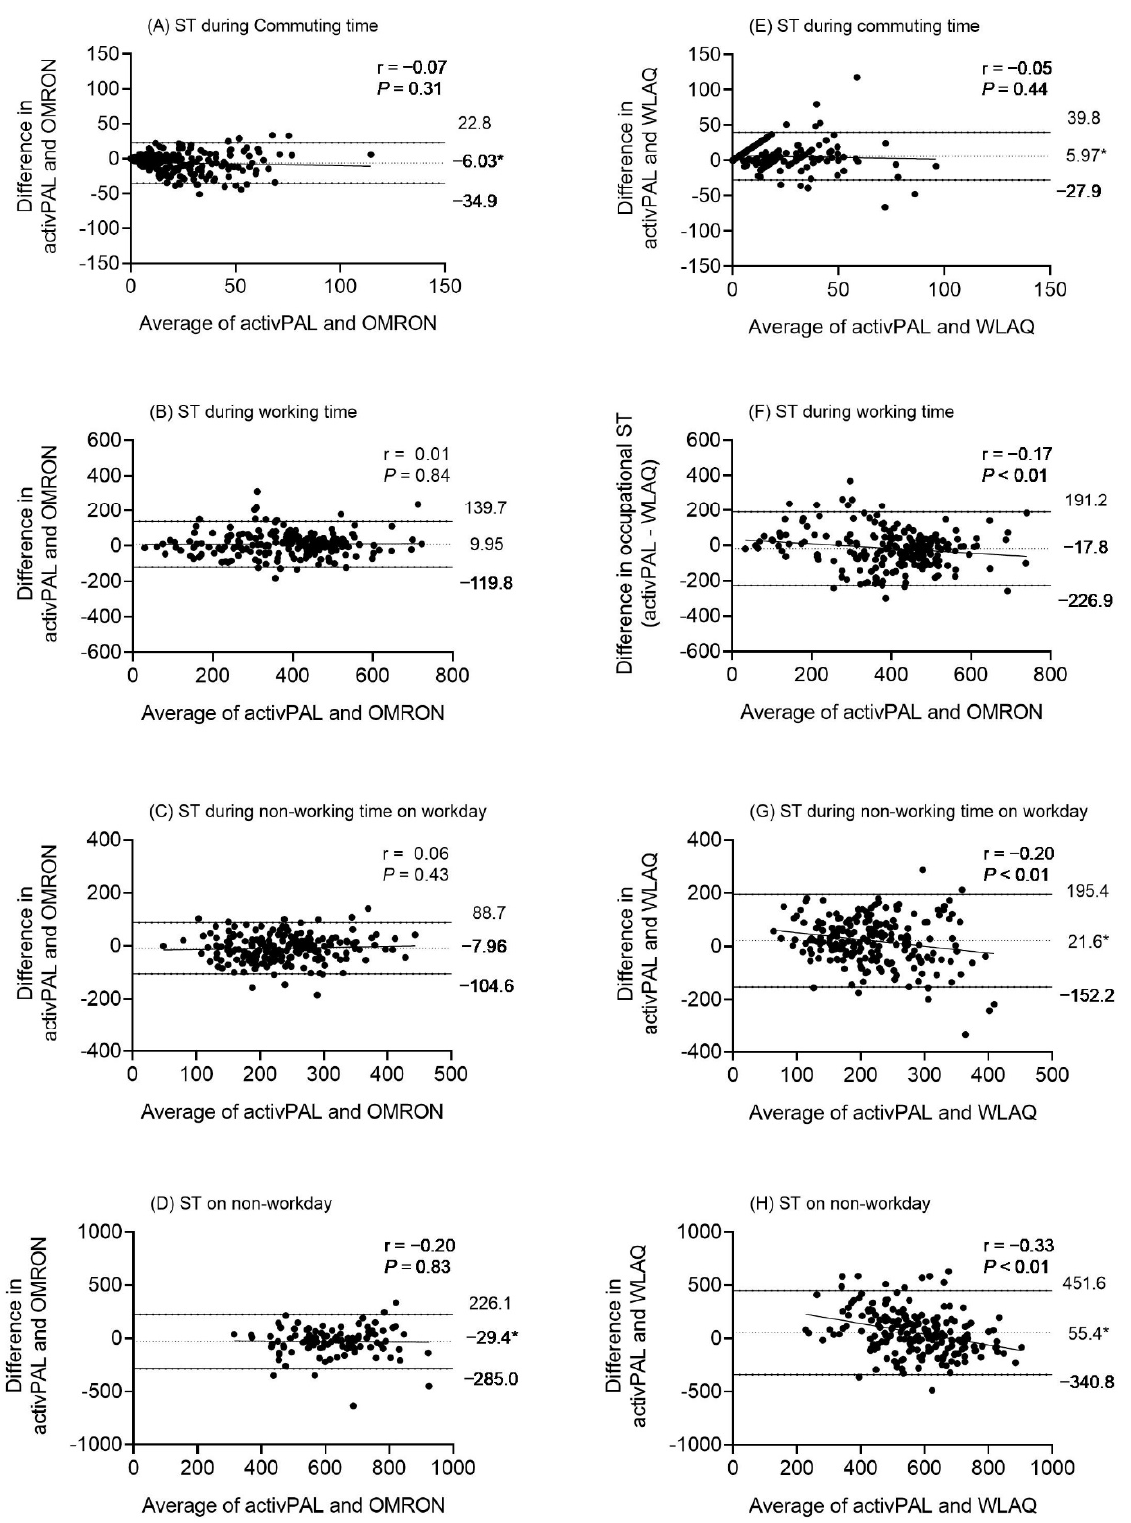
Figure 1. Bland–Altman plot comparing OMRON (left side) and WLAQ (right side) with the activPAL criterion. ( A , E ) ST at commuting, ( B , F ) ST at working time, ( C , G ) ST at non-working time on workdays, and ( D , H ) non-workdays. The mean difference is shown as a dashed line, and the 95% limits of agreement appear as solid lines. The correlation coefficients between X and Y are shown. * Significant mean difference ( p < 0.05).